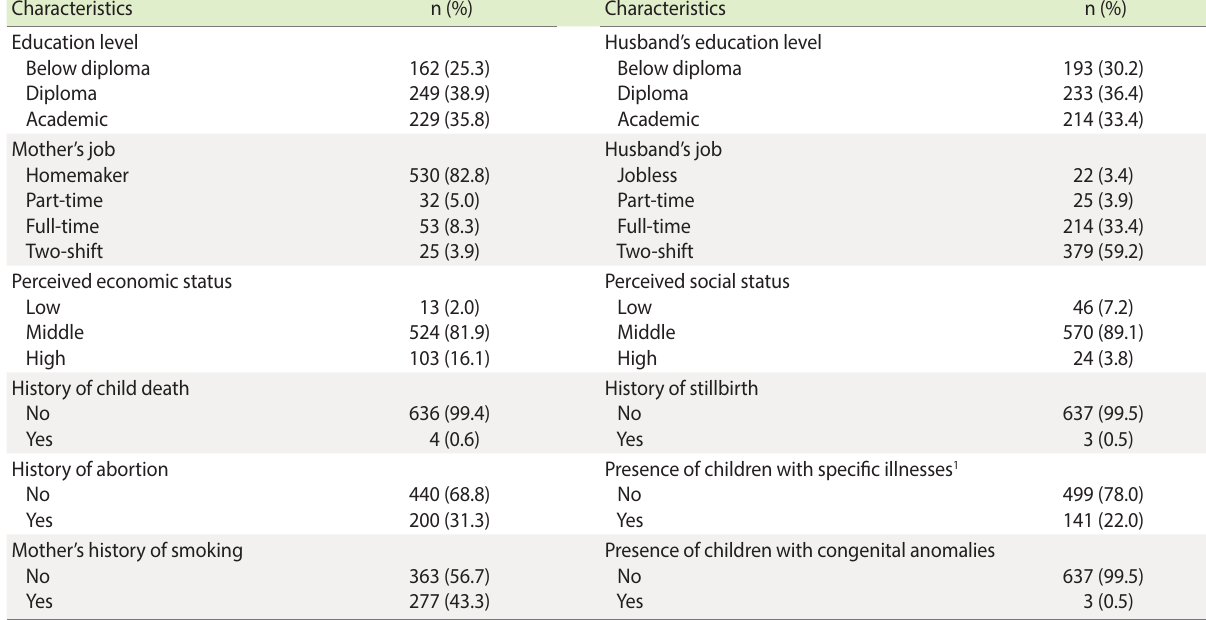
Table 1. Demographic characteristics of the mothers who participated in all three interview phases Characteristics